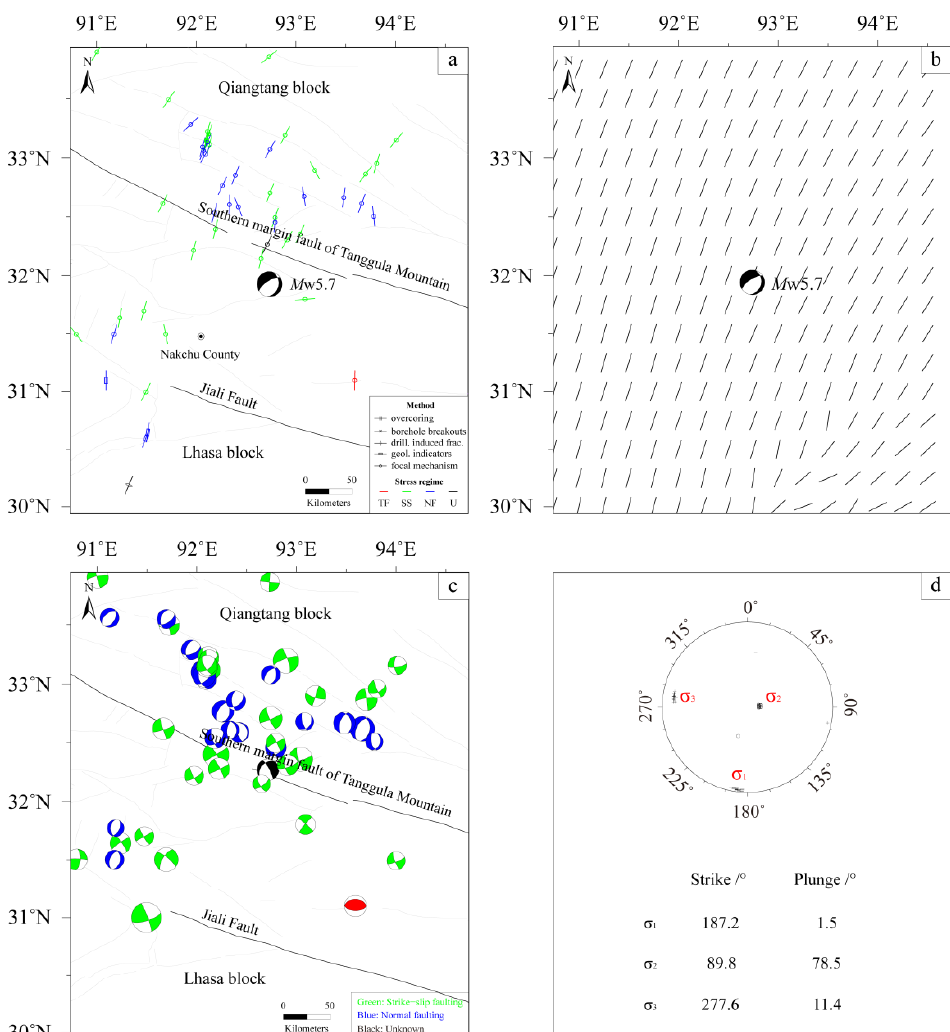
Figure 5. Tectonic stress fields around the epicenter of the Nakchu earthquake. Panels ( a , b ) represent stress data around the epicenter and the orientation of the horizontal maximum principal stress after smoothing, respectively; Panels ( c , d ) represent the focal mechanism solutions of historical earthquakes ( M ≥ 4.3 ) and the inversed regional principal stress, respectively.